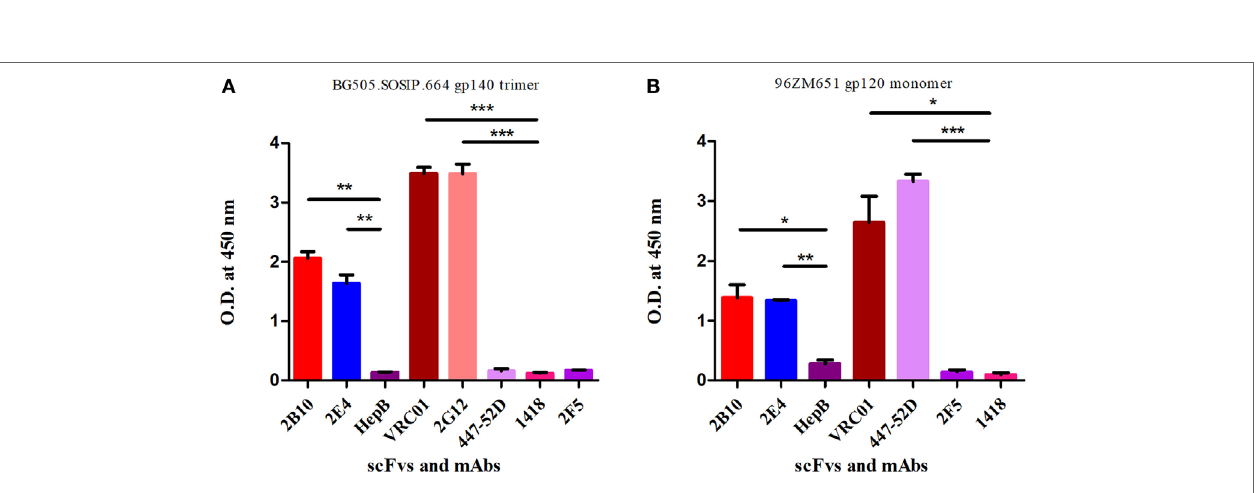
FigUre 4 | ELISA binding reactivity of 2B10 and 2E4 scFvs with HIV-1 monomeric and native-like trimeric envelope glycoproteins. ELISA was done to determine binding reactivity of the scFvs with (a) native-like HIV-1 BG505-SOSIP.664 D-7324 gp140 trimeric protein at 2 µg/ml. The anti-HIV-1 mAbs VRC01 and 2G12 were used as positive controls and anti-HIV-1 gp41 (MPER) 2F5, anti-V3 mAb 447-52D, anti-parvovirus mAb 1418, and anti-hepatitis scFv HepB were used as negative controls. (B) The binding analysis of scFvs with subtype C 96ZM651 gp120 monomer. The anti-HIV-1 gp120 mAbs VRC01 and 447-52D were used as positive controls and mAb 2F5, HepB scFv, and mAb 1418 were used as negative controls. Mean binding titers were compared with negative control using unpaired t -test. P values < 0.05 were considered as significant, (**) if p < 0.01 and (***) if p < 0.001.